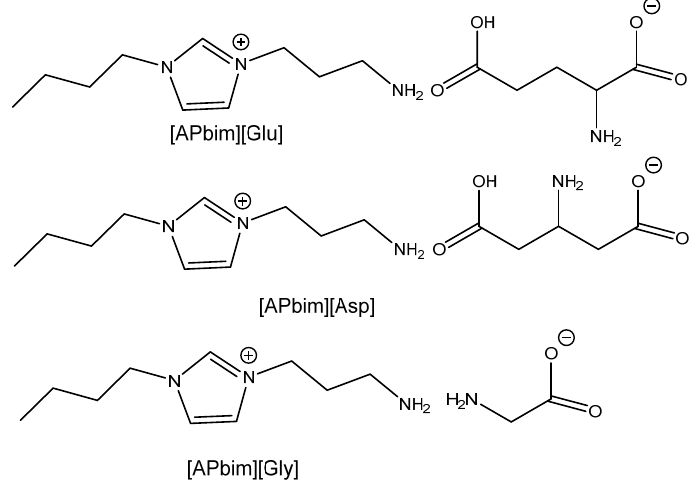
Figure 17. Structures of dual amino-functionalized IM-based ILs [102].